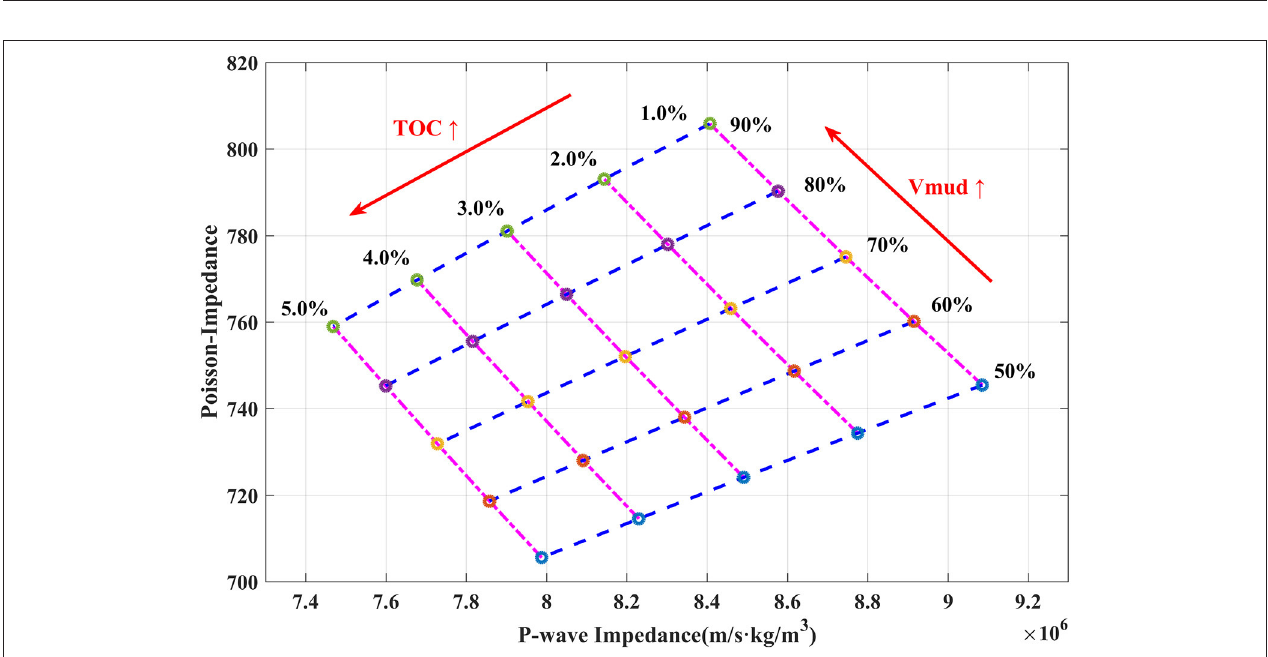
as σρ ), respectively. V P and I P have better sensitivities to the mean values of the elastic parameters at the mudstone (or high-quality source rock) and sandstone (or non-high-quality the high-quality source rock, and the Poisson’s ratio and source rock), respectively. P ∗ is the SD of the elastic parameter Poisson impedance are more sensitive to the mudstone. std at the mudstone (or high-quality source rock). Therefore, the Poisson’s ratio and Poisson impedance Figure 10 displays the sensitivity coefficients for can be considered as indicators for discriminating the mudstone, and then V P and I P are used to identify discriminating the high-quality source rock and mudstone the high-quality source rock from the distribution of of different elastic parameters, including V P , V S , I P , V P / V S , the Poisson’s ratio (denotes as σ ), and Poisson impedance (denotes